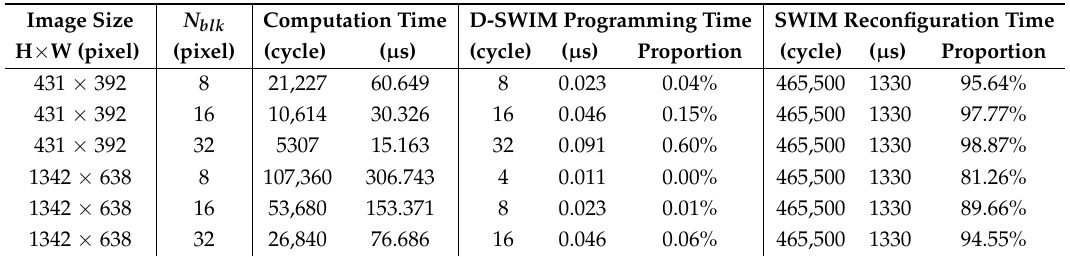
Table 4. Time period of dynamic programming of D-SWIM and partial reconfiguration of SWIM. Image